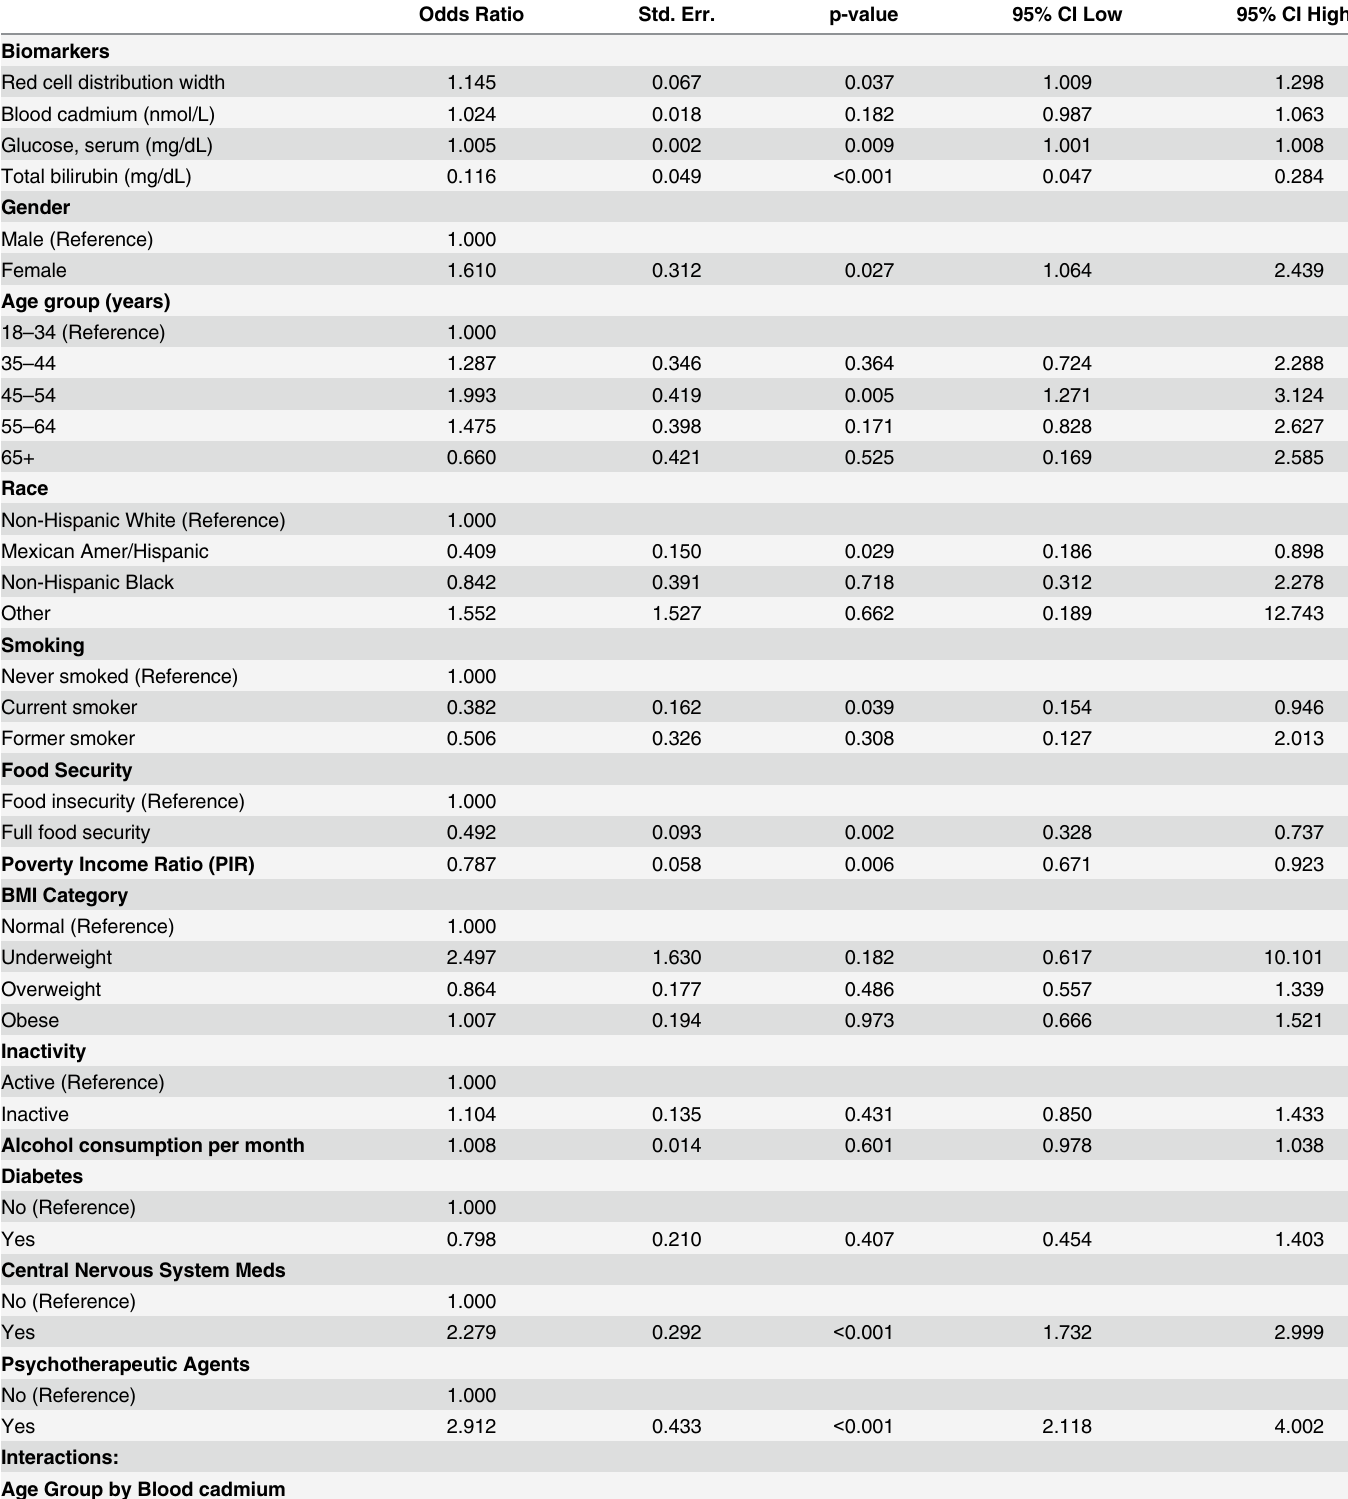
Table 5. Final Multivariate Logistic